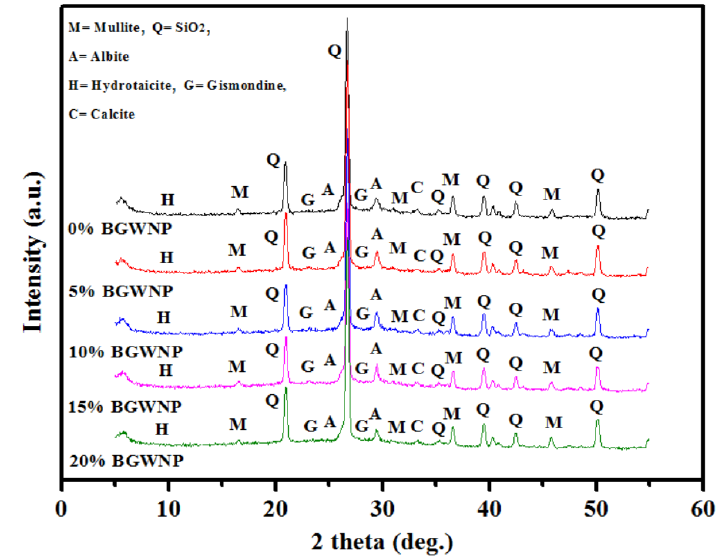
Figure 12. Effect of various BGWNP contents on structures of prepared AAMs .